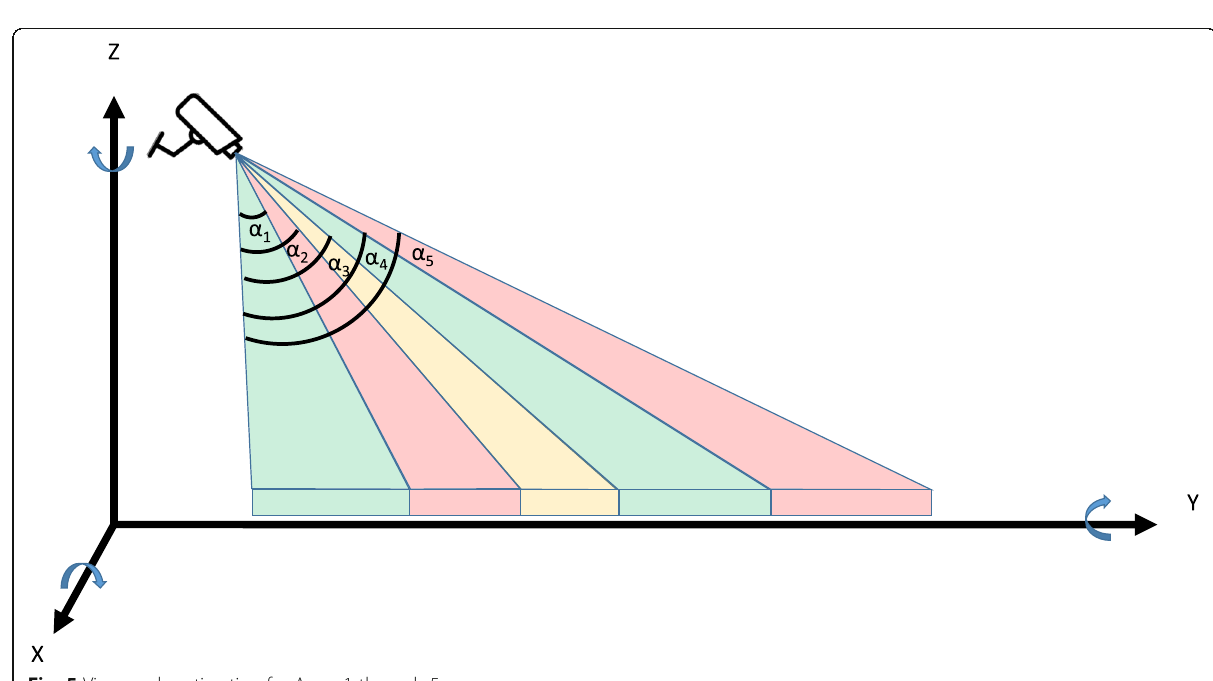
Fig. 5 View angle estimation for Areas 1 through